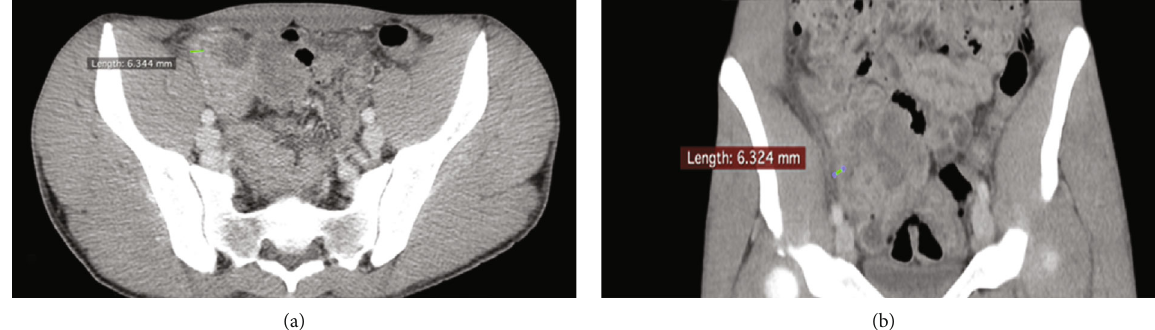
Figure 1: CT of the abdomen showing a thick-walled caecum, with adjacent fat stranding and a small volume of adjacent free fl uid: (a) axial section and (b) coronal section.